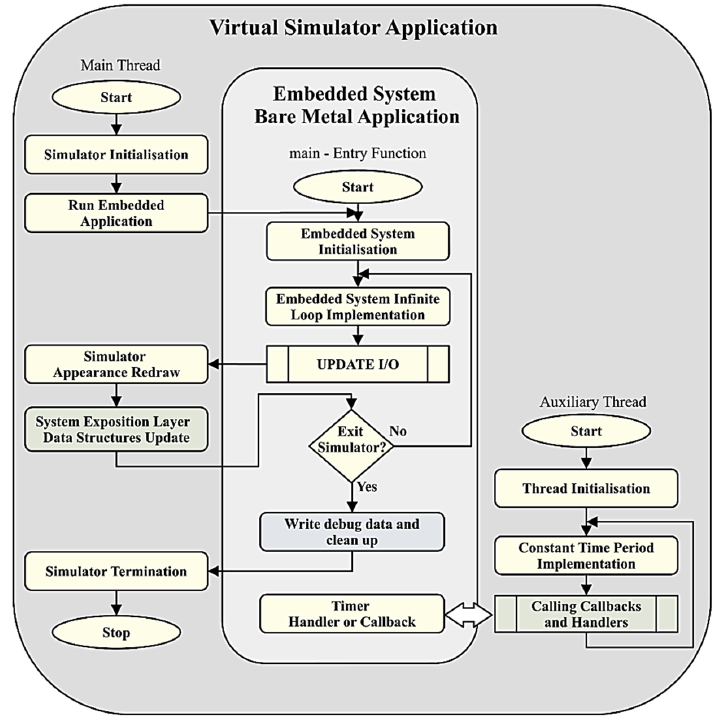
Figure 10. Rapidly developed stand ‐ alone virtual ‐ simulator application architecture .